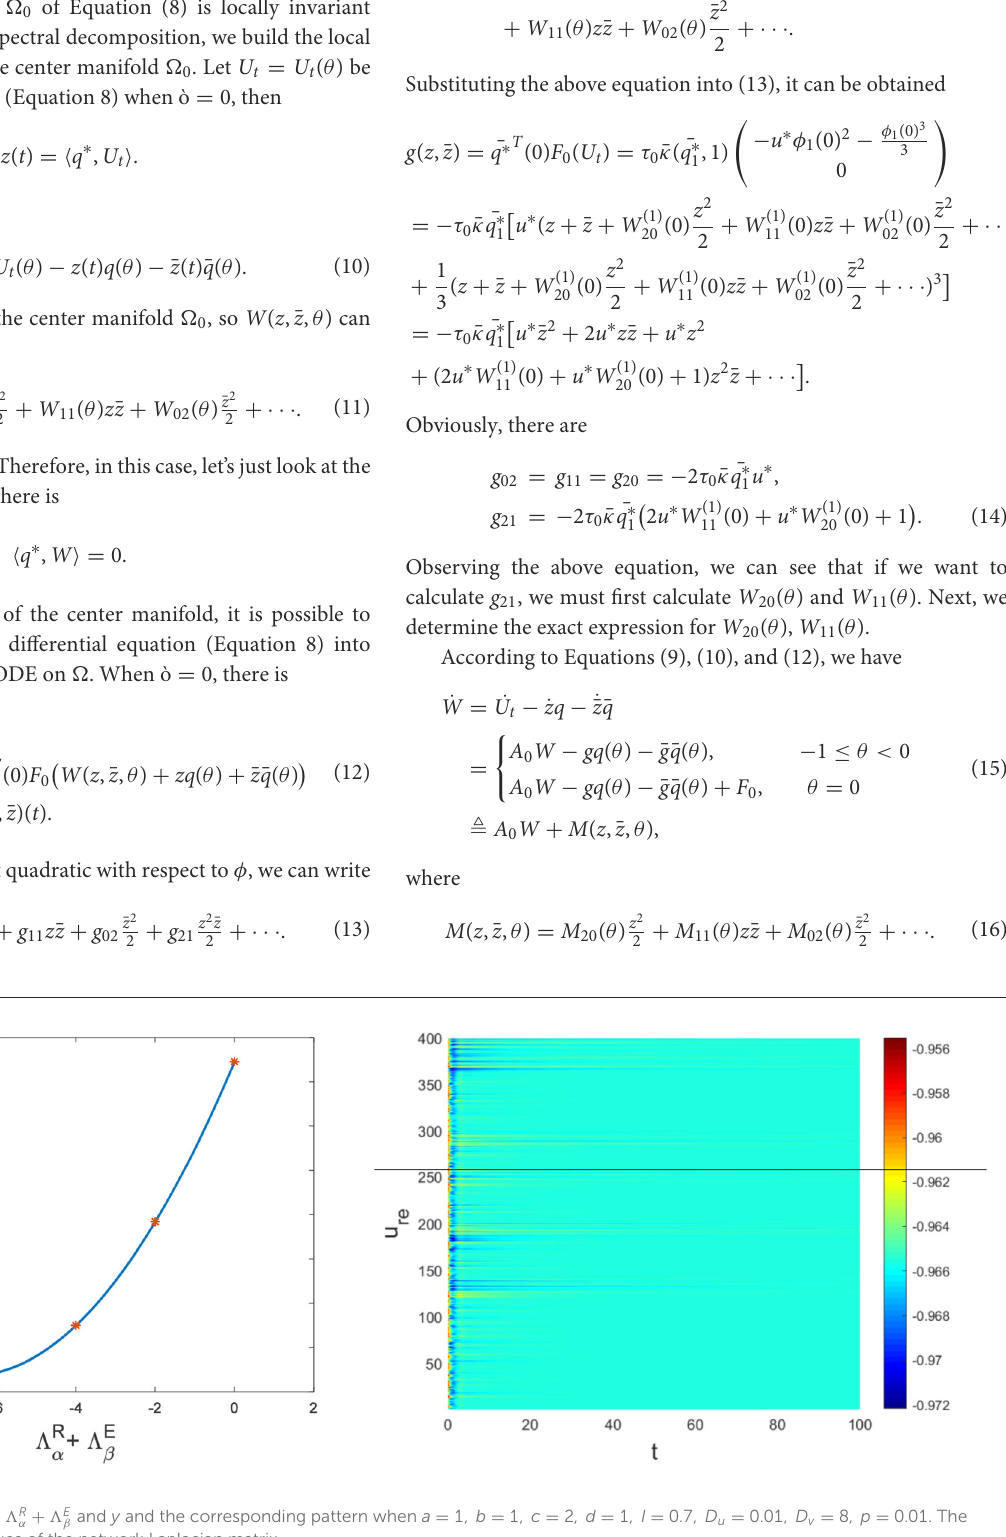
FrontiersinPsychiatry